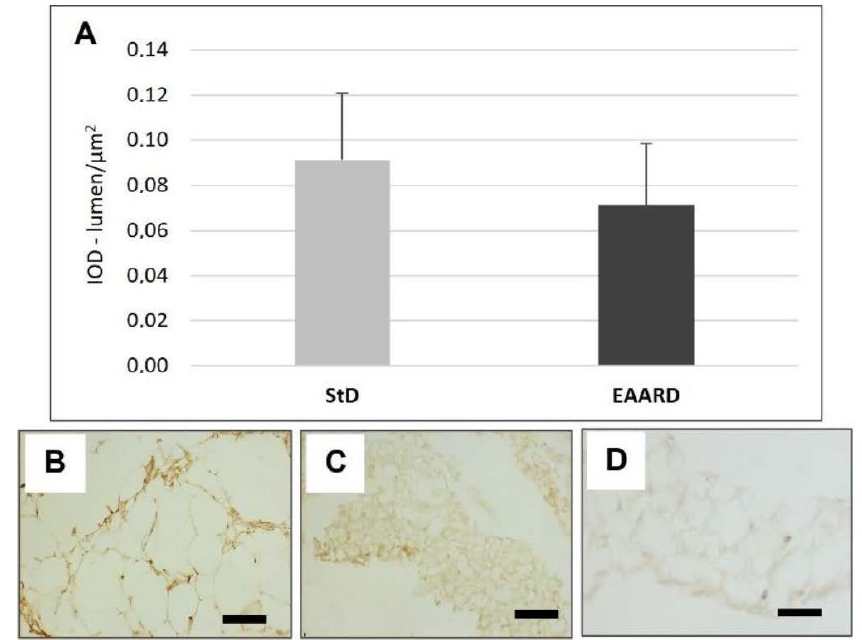
Figure 8. ( A ): Optical density for FADD immunostaining in rpWAT ( t = 1.402, p = 0.322) according to diet (mean ± sd). ( B , C ): Representative images of rpWAT IHC in StD and EAARD-fed mice, respectively. ( D ): Negative control performed by omitting the primary antibody. Original magnification 20×; scale bar 50 μm.